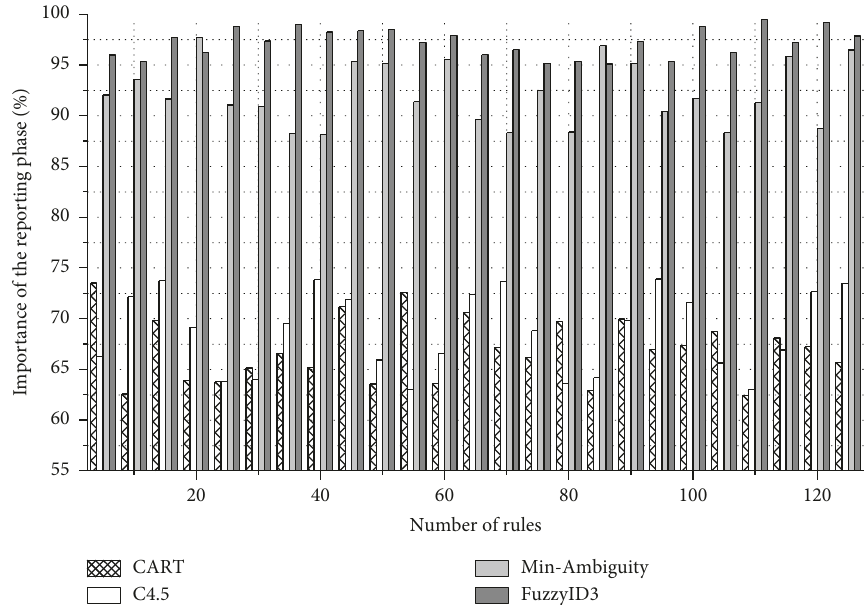
Figure 9: The importance of algorithms to the internal audit reporting